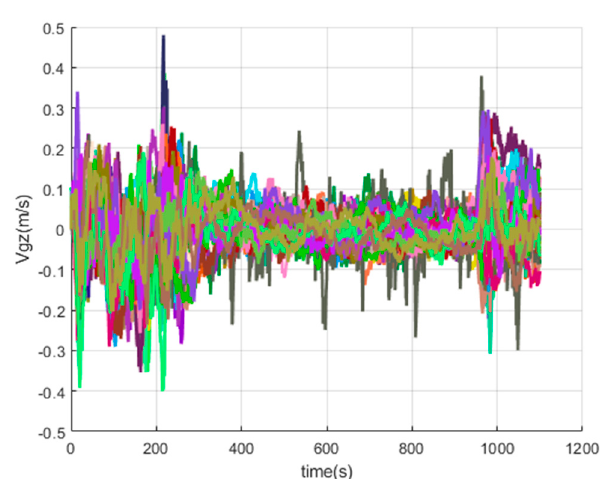
/ GPS in the LCEF frame.